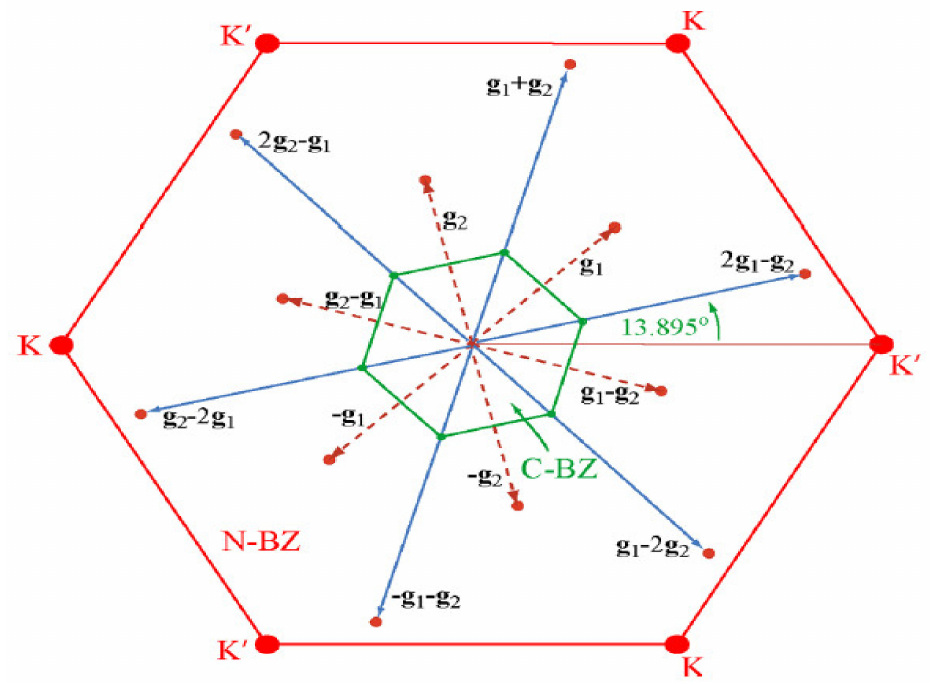
Figure 9. Normal (red) and commensurate reconstructed (green) Brillouin zone of monolayer 2 H -TaSe 2 . The equivalent Γ points in the first extended Brillouin zone and second extended Brillouin zone are connected to Γ by red and blue vectors, respectively. Reprinted with permission from Reference [127]. Copyright 2015 by the American Chemical